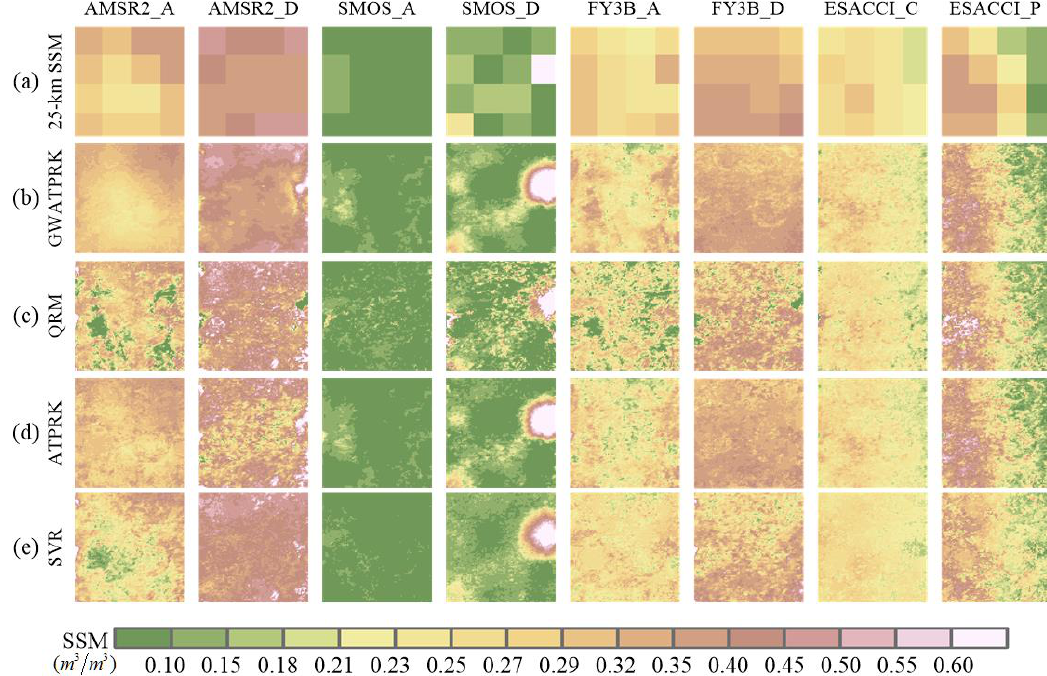
Figure 7. Naqu area on 13 August 2012. ( a ) Various 25 km SSM images and downscaled 1 km SSM images derived using the four methods: ( b ) GWATPRK, ( c ) QRM, ( d ) ATPRK, and ( e ) SVR.